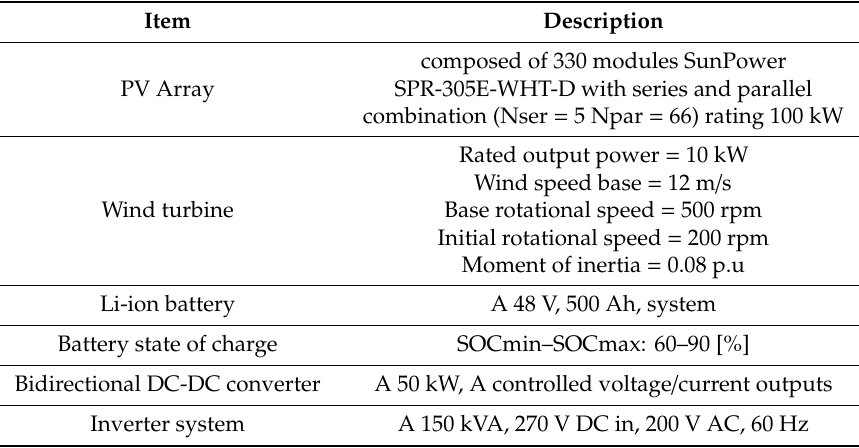
Figure 12. Daily profiles of renewable power generation and load in the studied system. Table 3. System parameters.